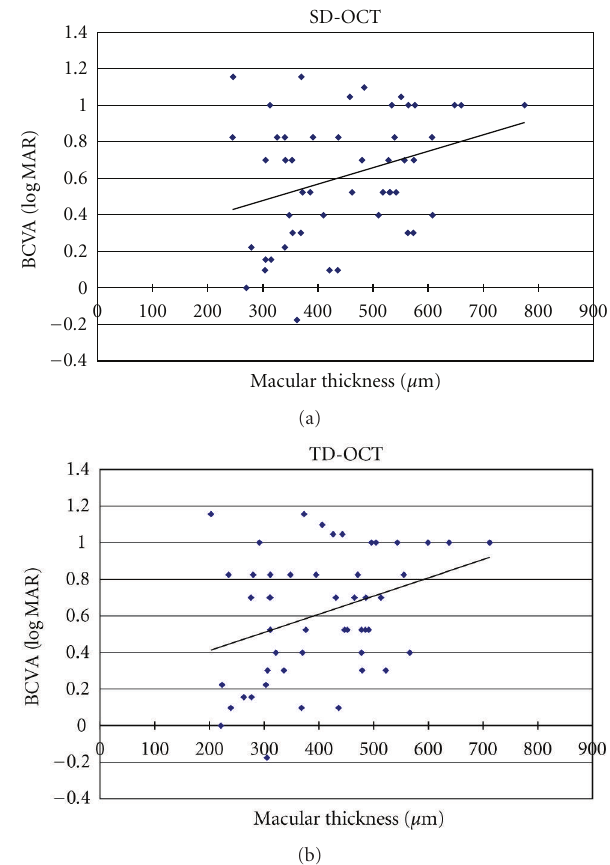
Figure 5: There is a significant correlation between TD-OCT (b) and SD-OCT (a) relationship for the BCVA and the retinal thickness (Pearson’s product moment correlation, TD-OCT, r = 0 . 34, P < 0 . 05; SD-OCT, r = 0 . 32, P < 0 .